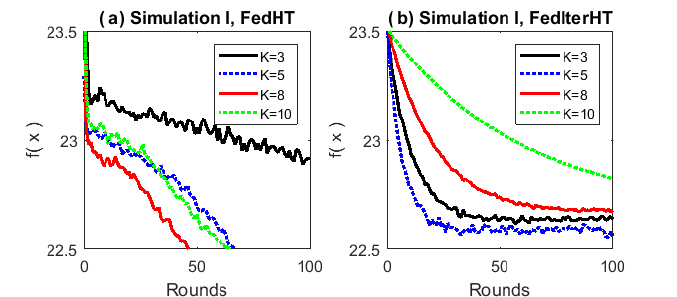
Figure 1. The comparison of proposed algorithms for different K values in terms of the objective function value vs. communication rounds ( a , b ).